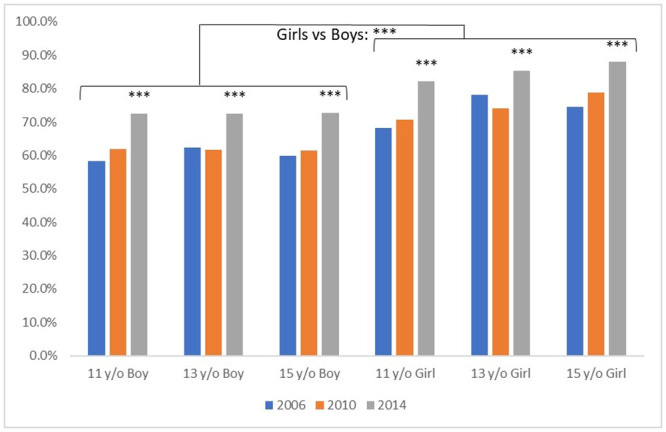
Proportion of adolescents brushing at least twice a day according to age, sex and year of the study.The proportion is significantly higher (***: p>0.0001) among girls than boys, and in 2014 compared to 2010 and 2006 in every age/sex group (***). A slightly increased toothbrushing frequency among older girls (13 y/o vs 11 y/o, and 15 y/o vs 13 and 11 y/o) can also be seen.